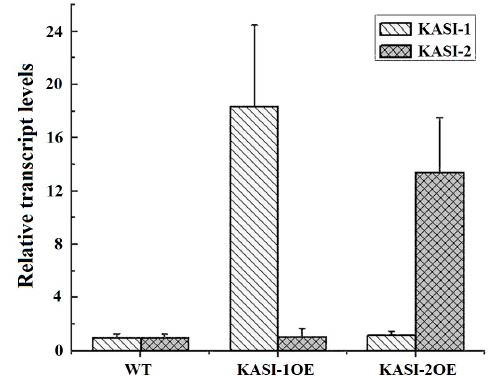
Figure 3. Relative transcript levels of KASI genes in all over-expressed lines and wild type (WT) tobacco. The expression of NtKASI-1 and NtKASI-2 gene in the 9th and 10th leaves in medium stage of wild type, KASI-1OE lines and KASI-2OE lines via qRT-PCR. The error bars represent the standard error with four independent lines.